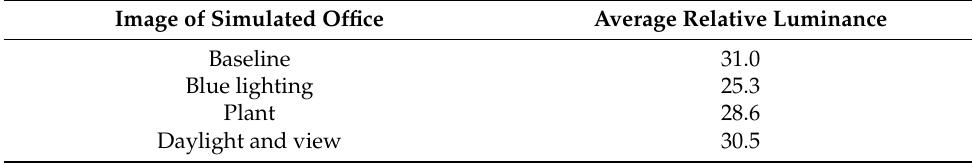
Table 4. Relative luminance of the four